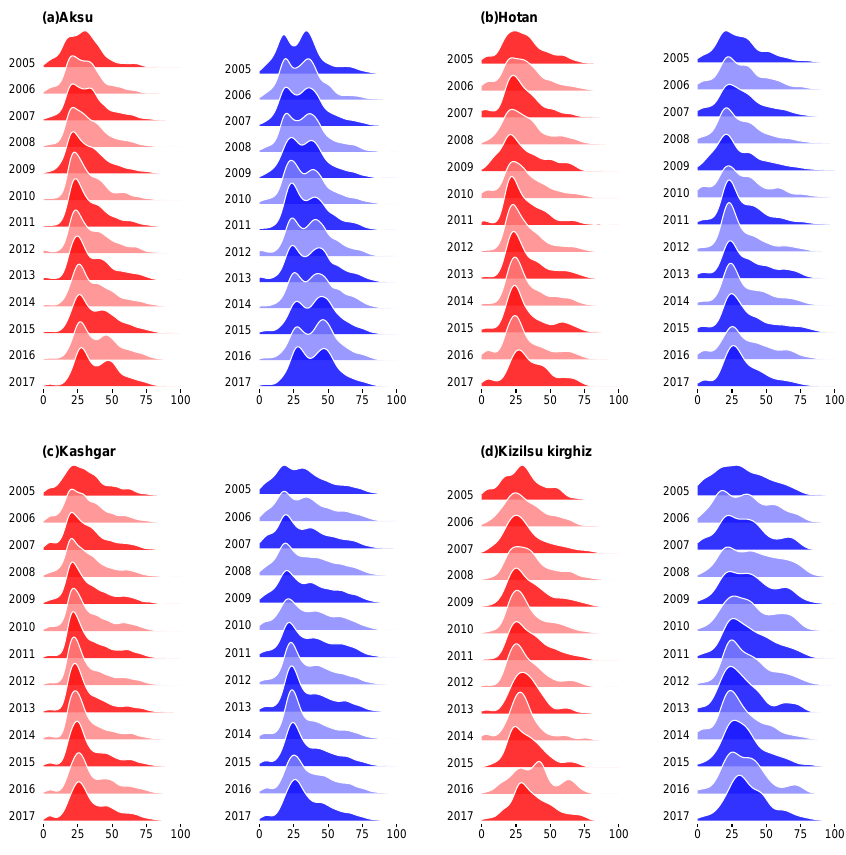
Figure 4. Age structure densities of HB among women and men in four regions of Xinjiang from 2005 to 2017. In each group, red meant female and blue meant male.